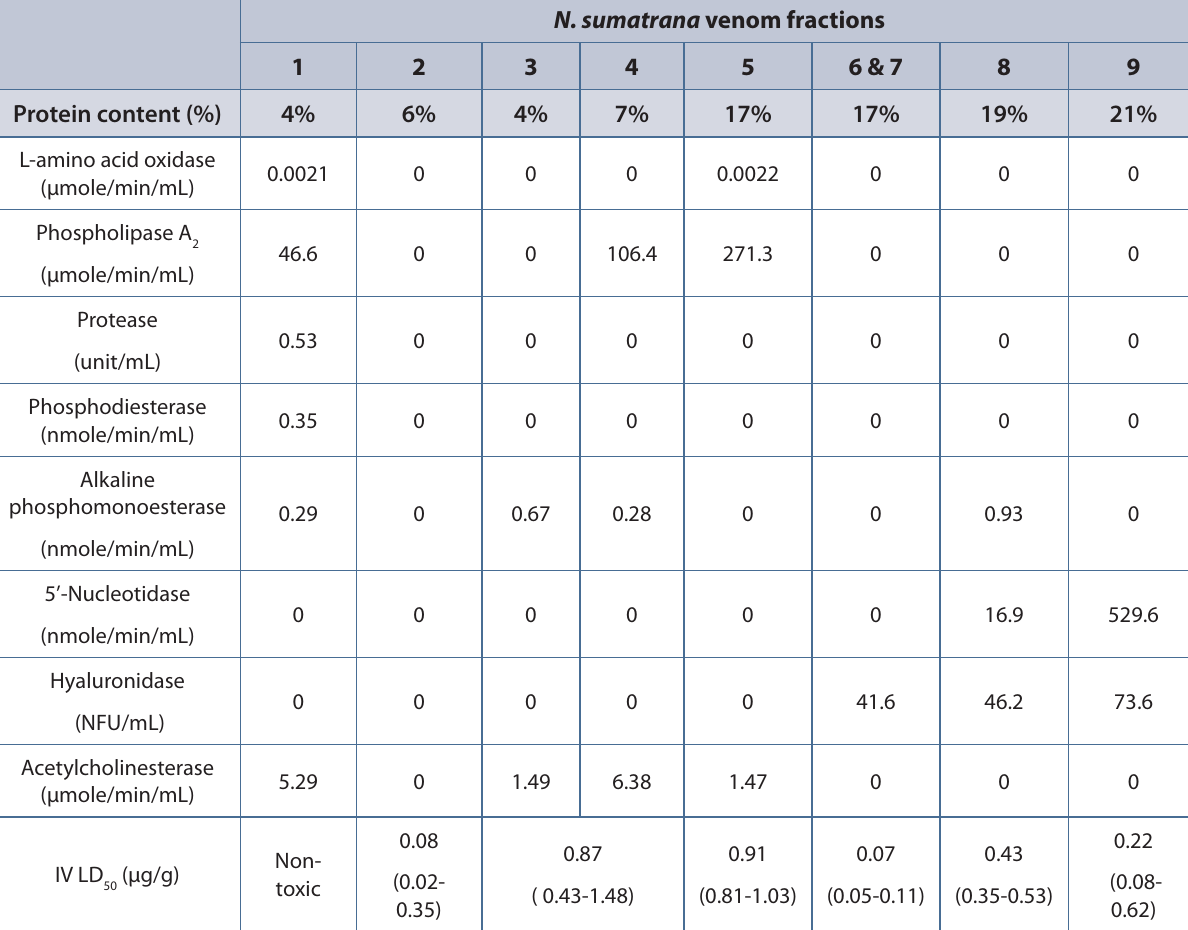
Table 2. Enzymatic and lethal activities of Naja sumatrana venom fractions obtained from Resource S ion exchange